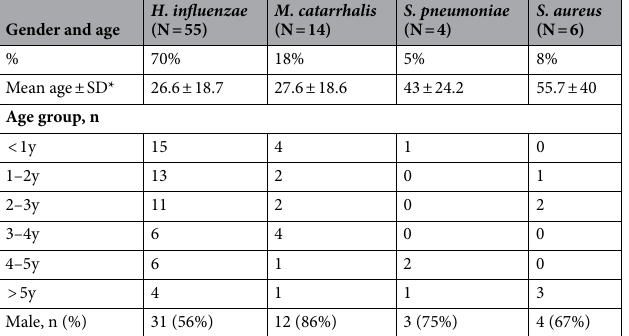
Table 1. Bacteriological culture results of conjunctiva discharge in children diagnosed of conjunctivitis with acute otitis media and/or acute bacterial paranasal sinusitis. *In